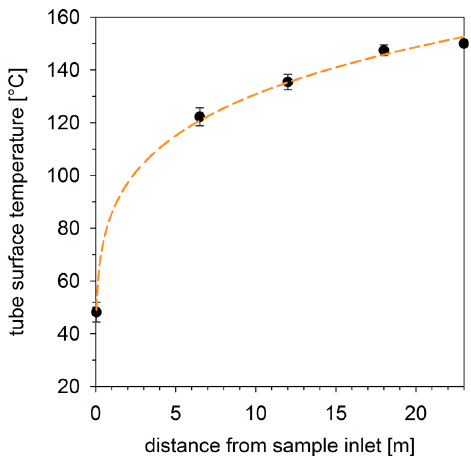
Fig. 2. Average profile of surface temperatures of the 1/2” inlet tube on both days of fertilisation; mean values ± standard